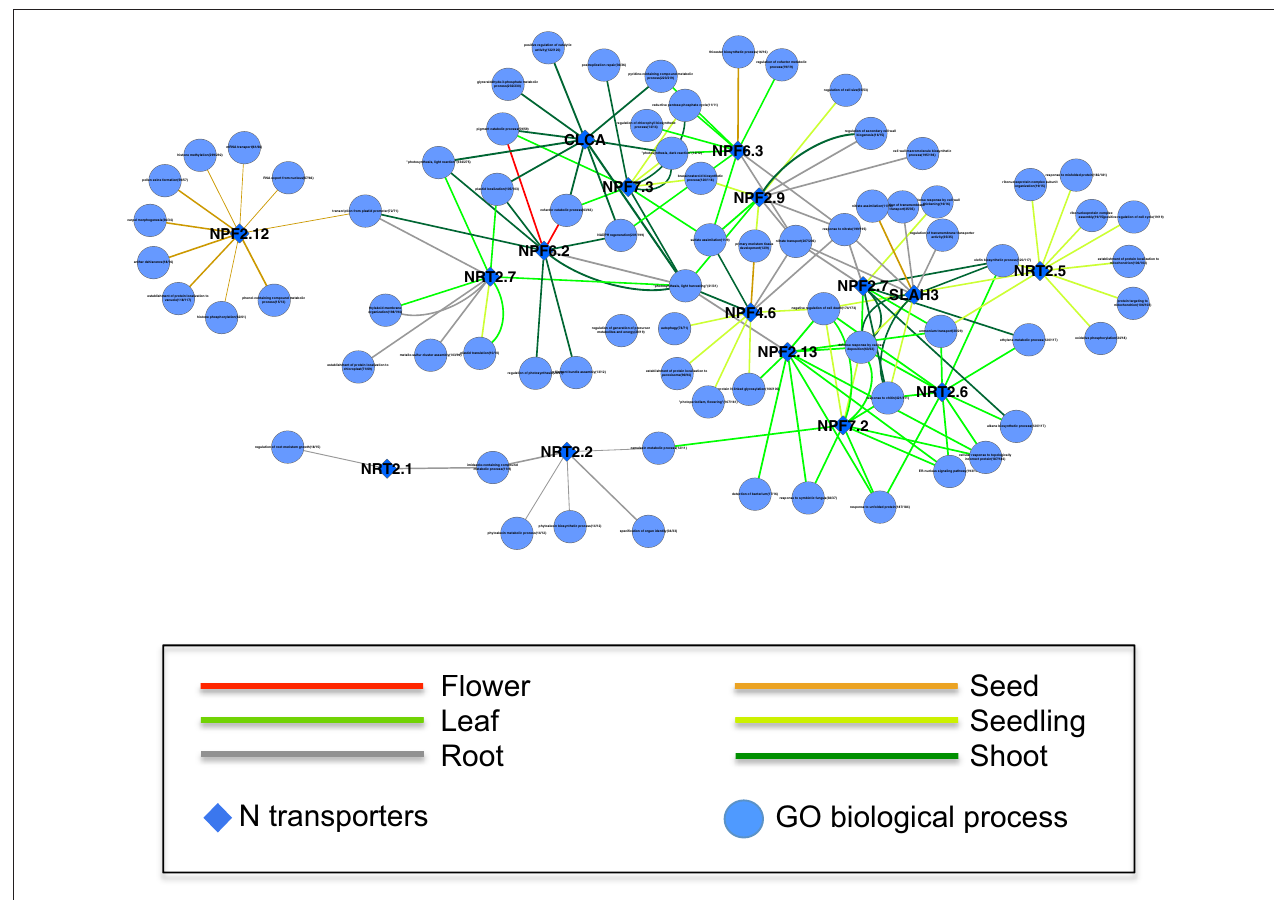
FIGURE 3 | A tissue-specific coexpression network between 17 N transporters and GeneOntology biological processes. Only the top 10 statistically significant coexpressed pathways coexpressed with each N transporter were included. The numbers following the name of GO biological process represent the number of genes within the process/the number of genes within the process and are on the microarray. The width of the edge is corresponding to the average weight of coexpression in GEO datasets of a specific tissue between the N transporter and genes from the GO category. Only the edges supported by at least 5 datasets of a specific tissue are shown here. A high resolution version of this figure and all the weights between N transporter and GO biological processes in all available tissues can be found in Supplemental Materials ( Figure S4 and Table S6